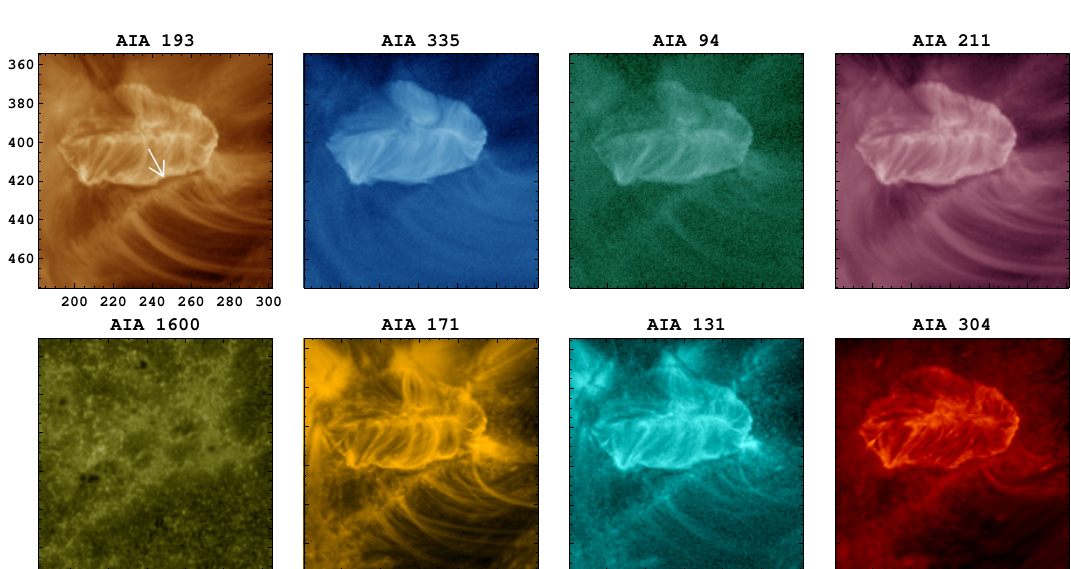
Figure 4: SDO/AIA observations of NOAA AR 11112 in UV and EUV channels. Tarr et al. (2014) estimate that, over the course of two days, the quantity of (steadily) reconnected flux between the emerging flux region and preexisting field is comparable to a large M- or a small X-class flare. Image courtesy of L. A.